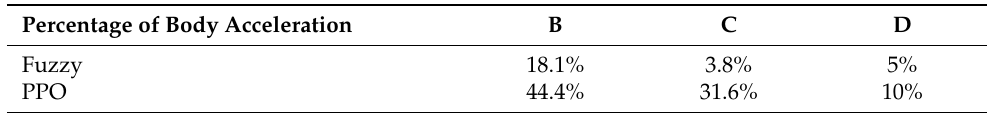
Table 7. The percentages of the RMS values of the two semi-active suspensions for a heavy vehicle under the same